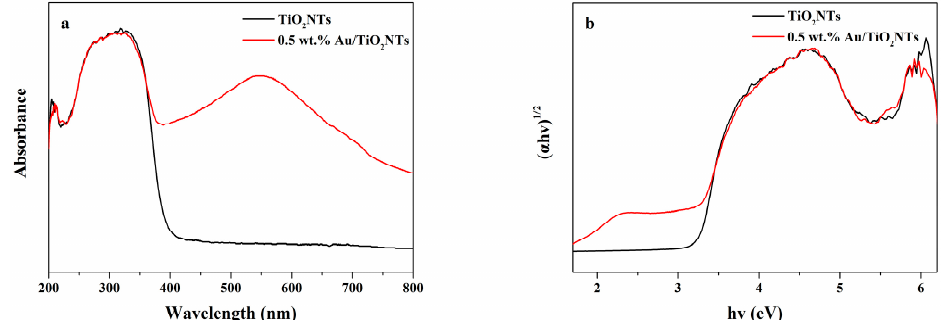
Figure 4. ( a ) UV–Vis DRS, and ( b ) bandgap energies of TiO 2 NTs and 0.5 wt.% Au/TiO 2 NTs.